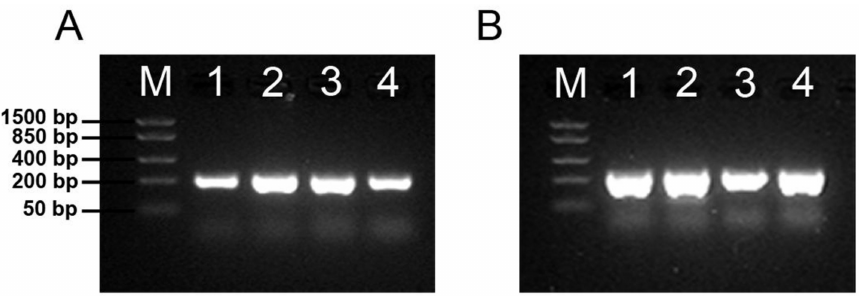
Figure 3. mRNA expression of bovine polysialyltransferases. Agarose gel electrophoresis of RT-PCR amplicons of ST8SIA2 ( A ) and ST8SIA4 ( B ) from total RNA of bovine udder tissue (1), brain (2), lung (3), and cultured primary bovine MECs (4). Lane M; FastRuler™ Low Range DNA Ladder (Thermo Scientific TM